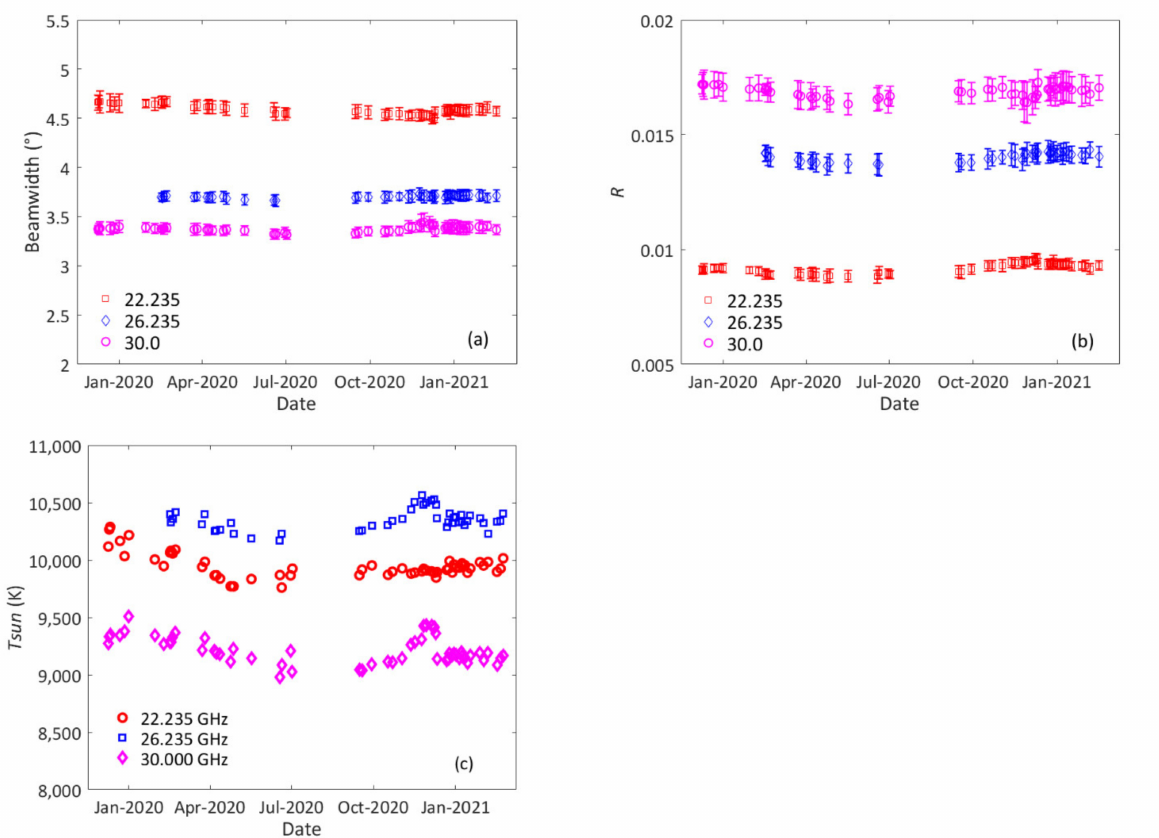
Figure 14. The annual variation of the daily mean beamwidth, the ratio R , and solar TB. The ratio, R , is the solar solid angle to the antenna solid angle and Tsun is the solar TB at the different frequencies. The markers are the observed daily means. ( a ) Beamwidth, ( b ) he ratio R , and ( c ) the daily mean solar